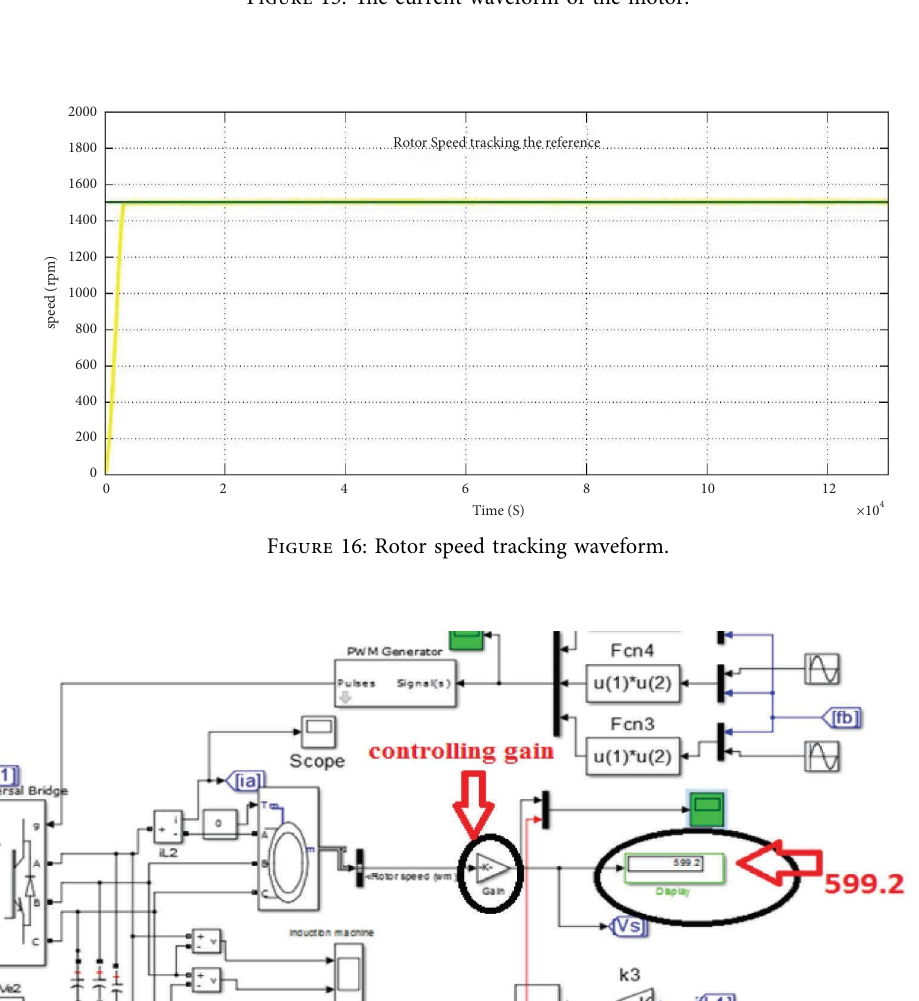
Figure 15: Te current waveform of the motor.